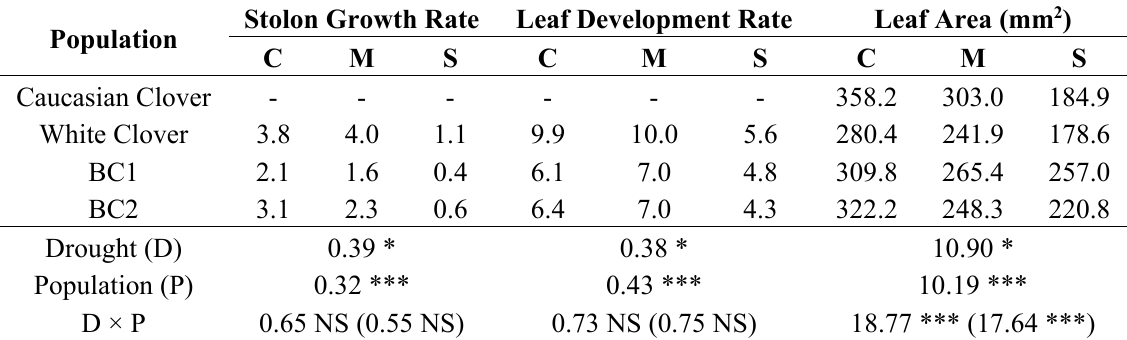
NS, not significant; * p < 0.05; *** p < 0.001; S.e.d. in brackets to be used when comparing means with same level of